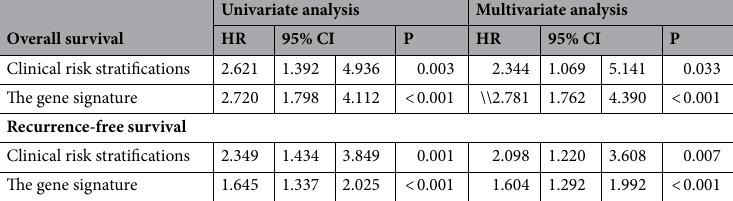
Table 3. Univariate and multivariate analysis of the clinical risk stratifications and the gene-signature based score using Cox